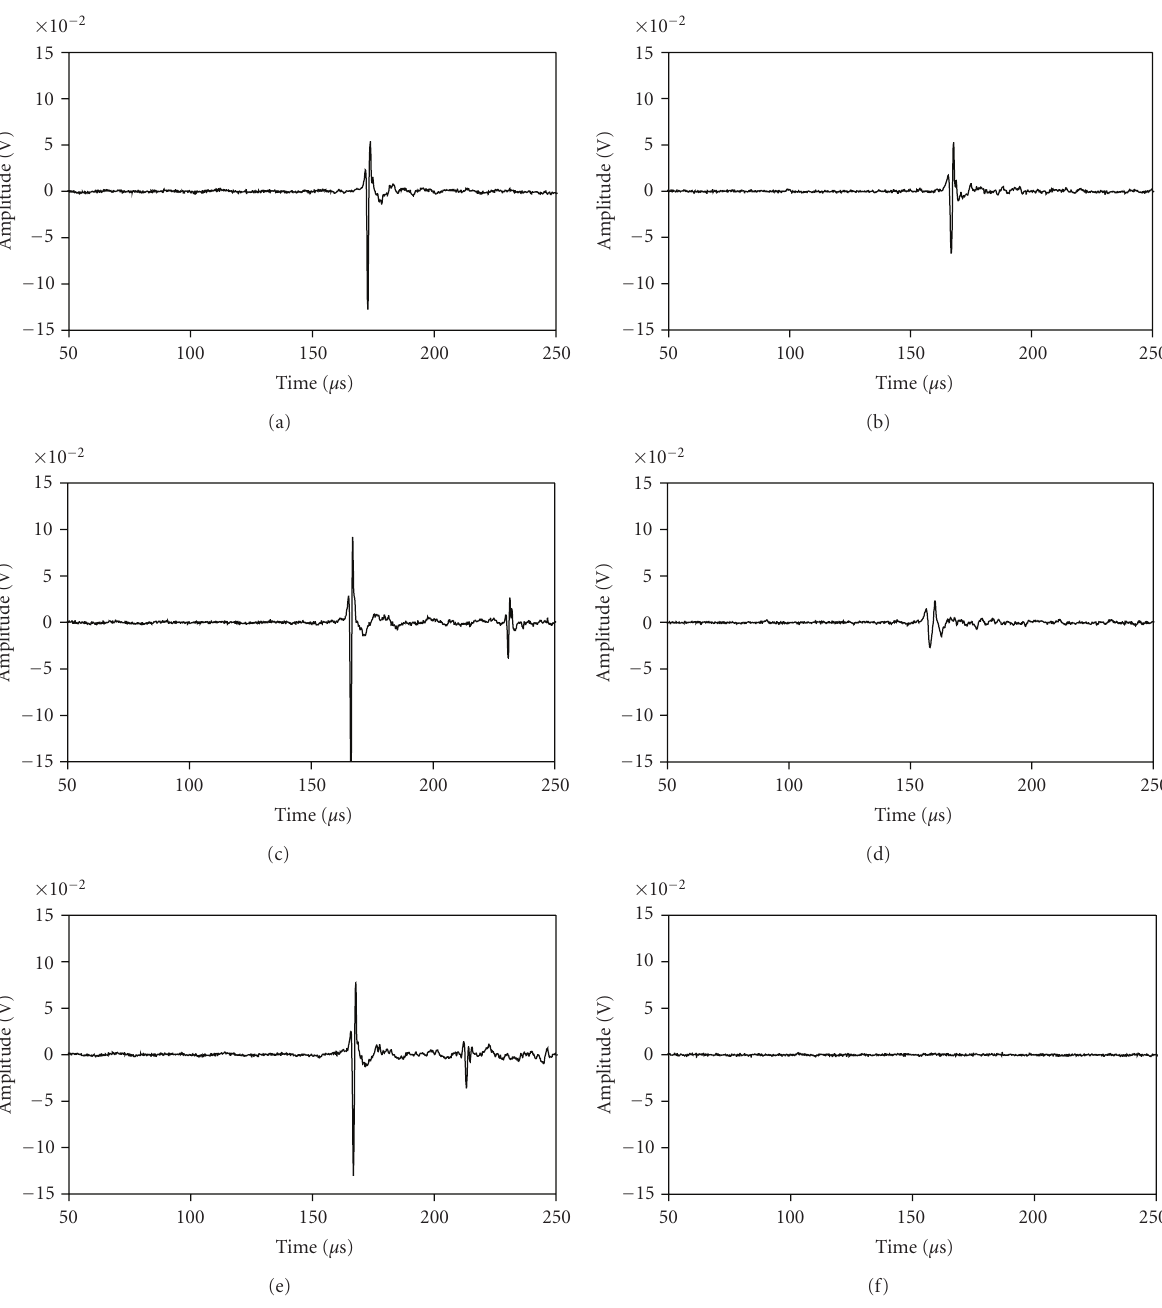
Figure 3: Typical waveforms detected by the hybrid laser/air-coupled transducer system. Time waveforms detected by the (a) rear and (b) front sensors when the inspection system is probing a pristine rail section. Time waveforms detected by the (c) rear and (d) front sensors when the inspection system is probing a transverse surface notch. Time waveforms detected by the (e) rear and (f) front sensors when the inspection system is probing a